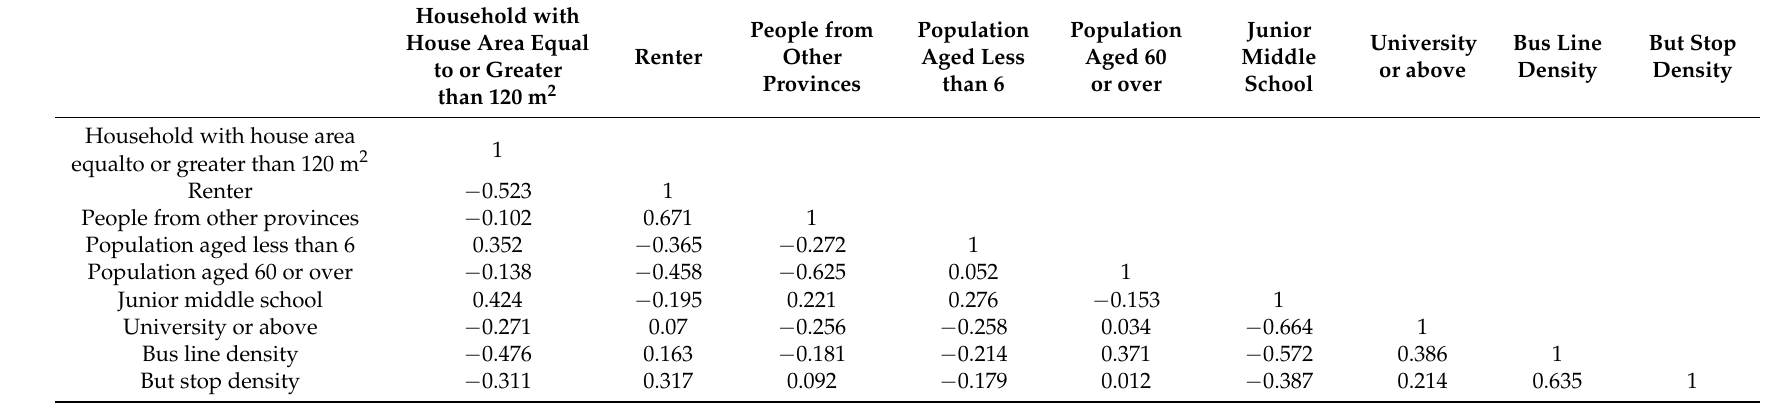
Table 2. Results of the Correlation